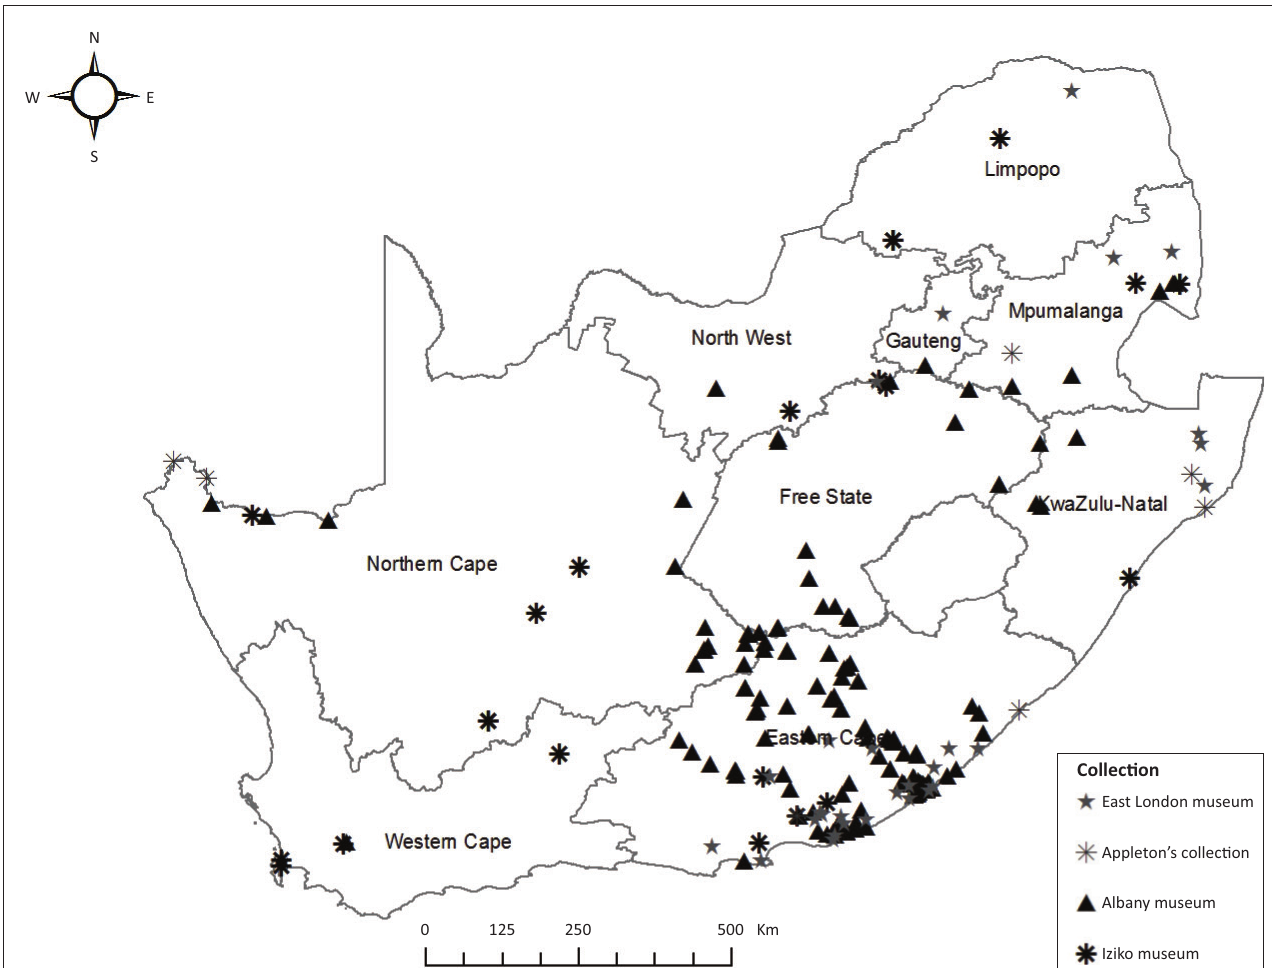
FIGURE 4: Distribution of Unio caffer in South Africa drawn using records from three South African museums (AMGS, ELM and SAMC) and personal collections by the third author